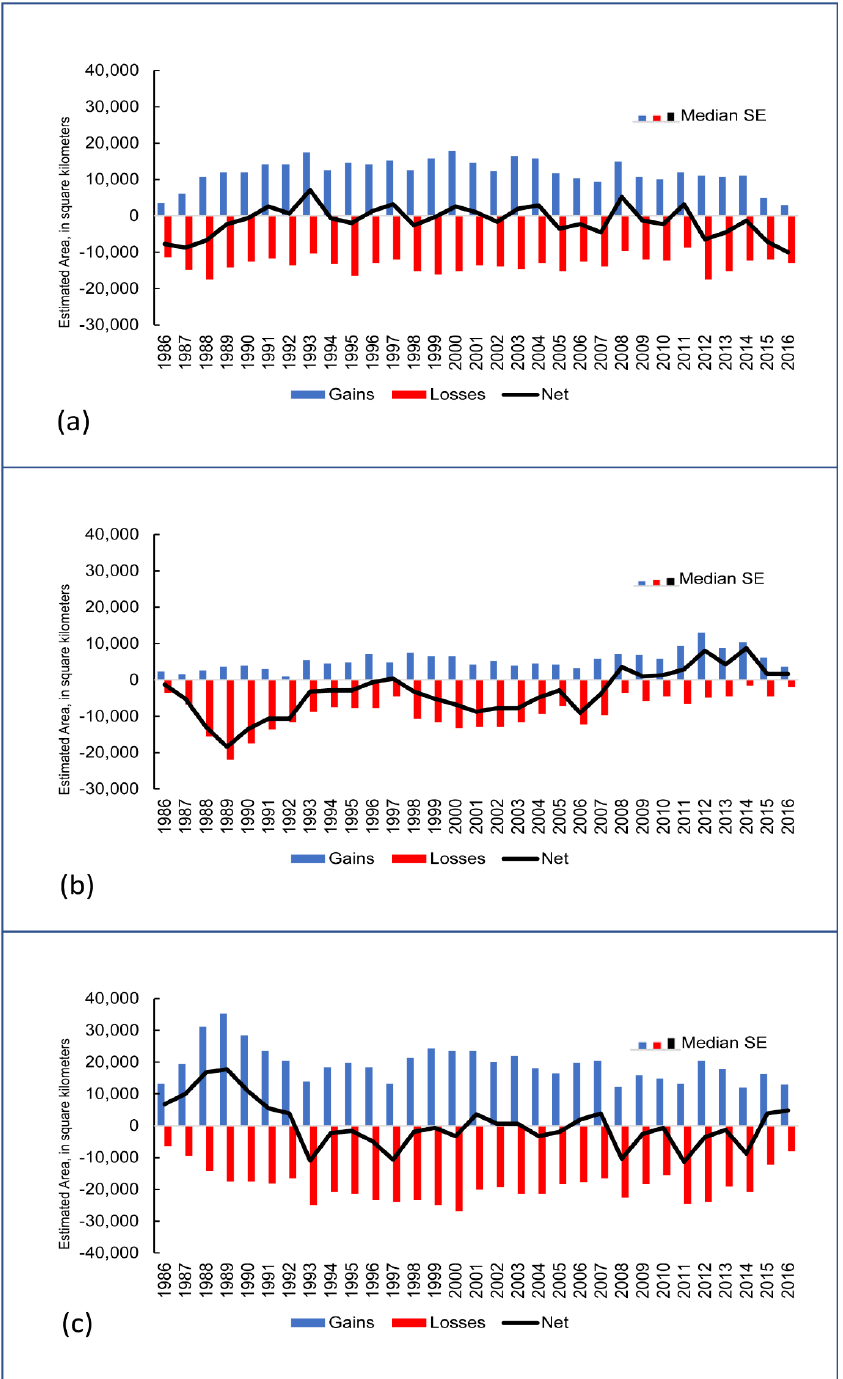
Figure 3. Annual gross gains, gross losses, and net change for ( a ) tree cover, ( b ) cropland, and ( c ) grass/shrub, 1985 – 2016 , with 1986 “change year” starting on 1 July 1985). The standard error (SE) inset represents the median of the annual standard errors (in square kilometers) for each estimate: tree cover — gain, ±1965; loss, ±2068; and net, ±2909; cropland — gain, ±1252; loss, ±1583; and net, ±2144; grass/shrub — gain, ±2501; loss, ±2501; and net, ±3540.